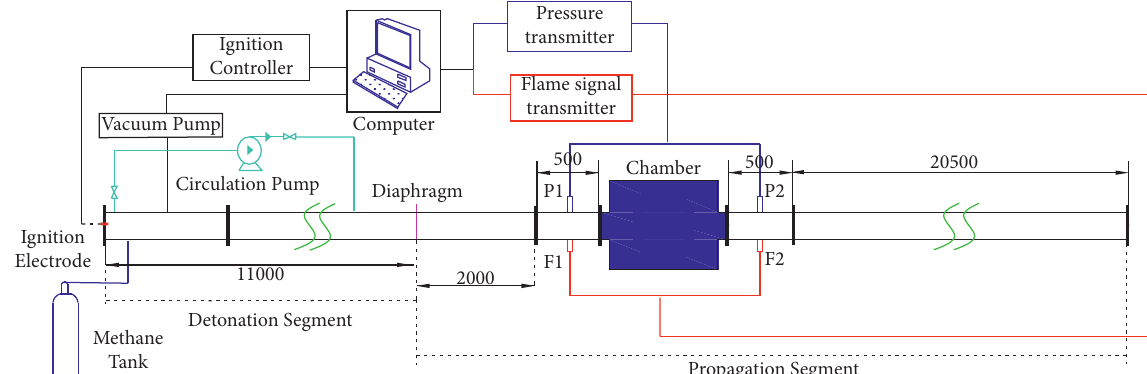
Figure 1: Chart of experimental system for gas explosion.